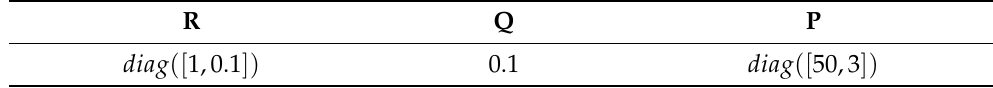
Table 2. NMPC cost